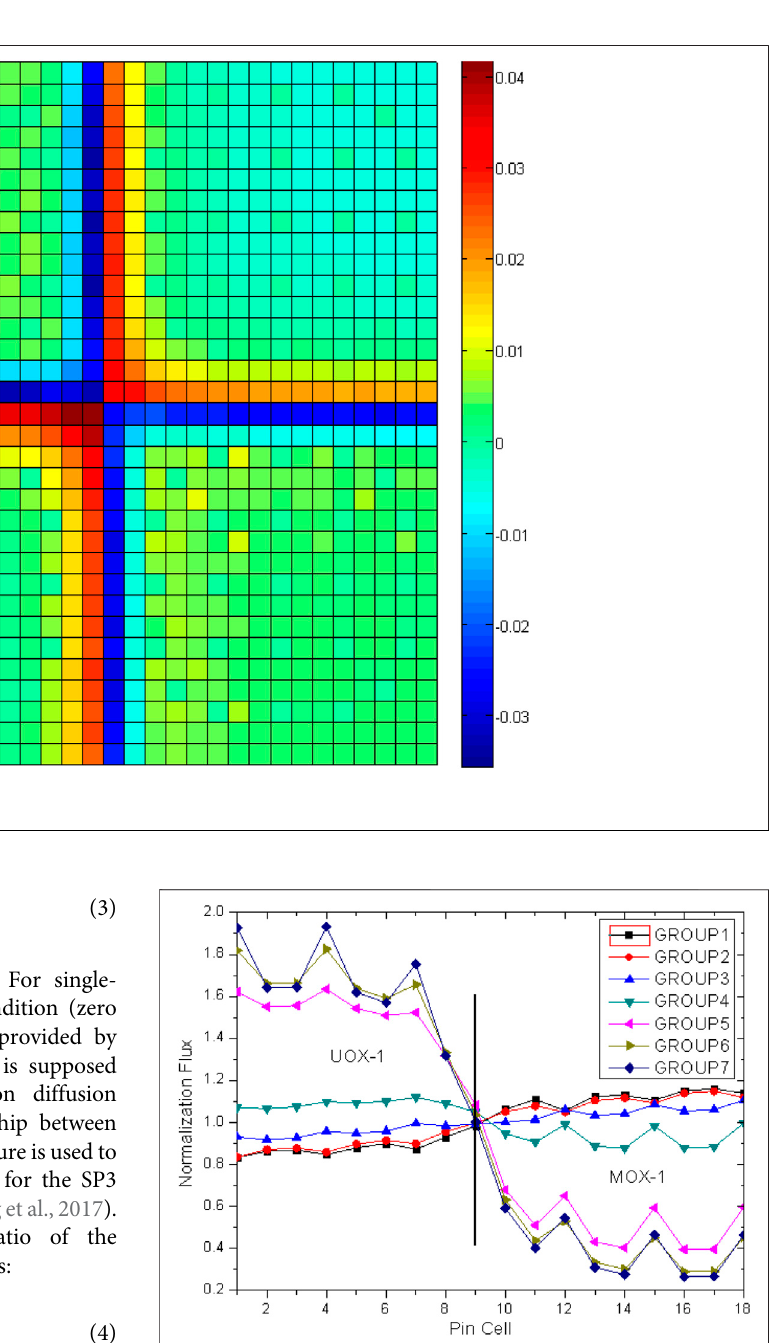
FIGURE 3 | The normalization neutron fl ux